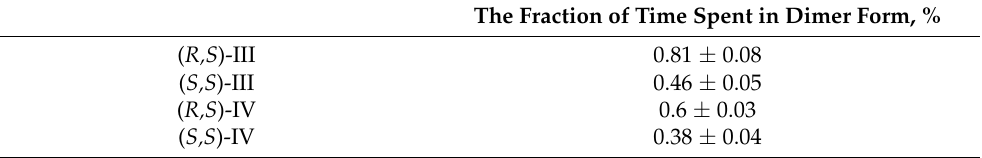
Table 8. The comparison of the possibility of dimer formation for various optical configurations of dyads IV and